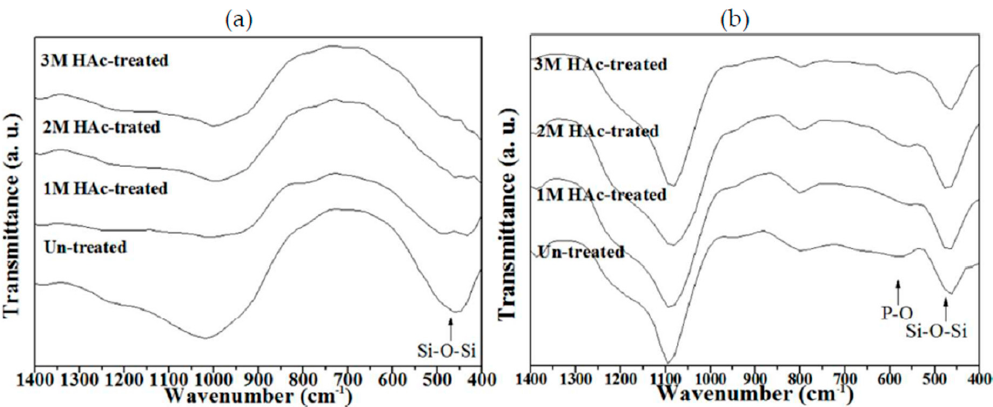
Figure 7. FTIR spectra of untreated and HAc-treated BG powders ( a ) before and ( b ) after immersing in SBF for 6 h.